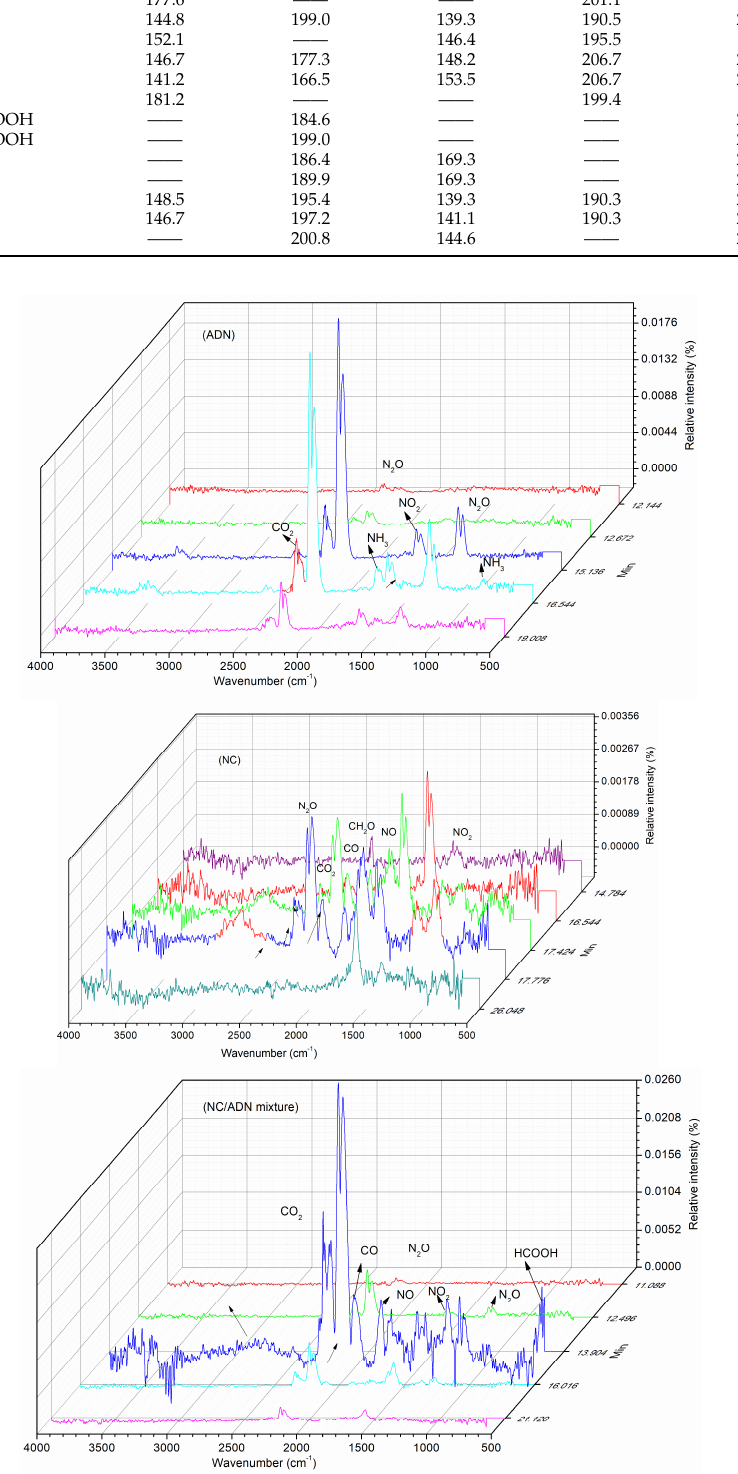
Figure 5. Gas products IR spectroscopy of ADN, NC and NC/ADN mixture at different moments.